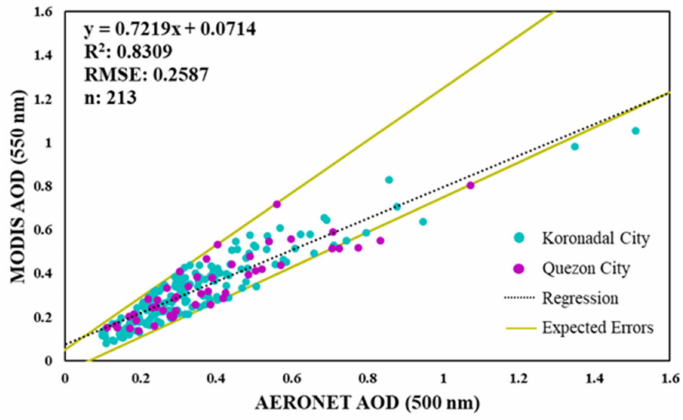
Figure 2. Scatterplot of MODIS AOD versus AERONET AOD from 2010 to 2020. A total of 213 samples were used in the analysis. Computed R 2 is 0.83 and RMSE is 0.26.